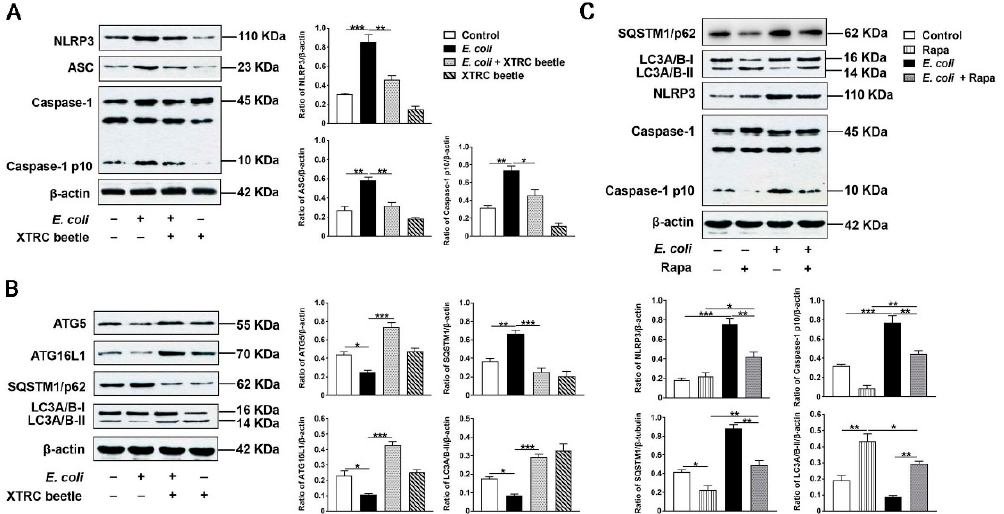
Figure 6. Effect of Z. morio hemolymph on the NLRP3 and ATG5/ATG16L1-mediated autophagy signaling pathway in E. coli -induced PMECs. ( A ) Western blotting analysis of NLRP3, ASC and Caspase-1. The right panel shows the protein quantification using ImageJ software (version 1.50). ( B ) Western blotting analysis of ATG5, ATG16L1, P62 and LC3A/B-II. The right panel shows the protein quantification using ImageJ software (version 1.50). ( C ) Western blotting analysis P62, LC3A/B-II, NLRP3 and Caspase-1 in PMECs after Rapa (1 µ M) pretreatment. The right panel shows the protein quantification using ImageJ software (version 1.50). XTRC beetle stands for Z. morio hemolymph-treatment. Data presented are means ± SEM ( n = 3 per group). * p < 0.05, ** p < 0.01, *** p < 0.001.